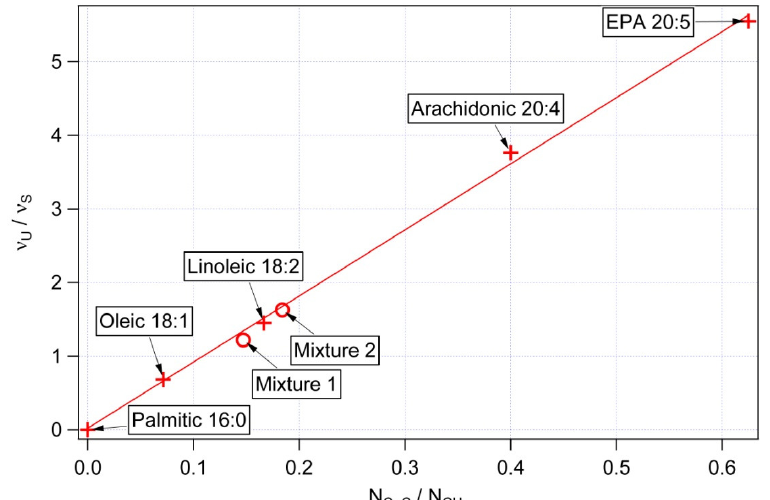
Figure 4. Dependence of the observed ratio ν at 1656 cm −1 and 1445 cm −1 on the molecule mass unsaturation N experimental data obtained with pure fatty acids, straight line is a fit of this data. Circles indicate verification data points obtained with mixtures of oleic and arachidonic acids of different molar ratios; this data was not included in the